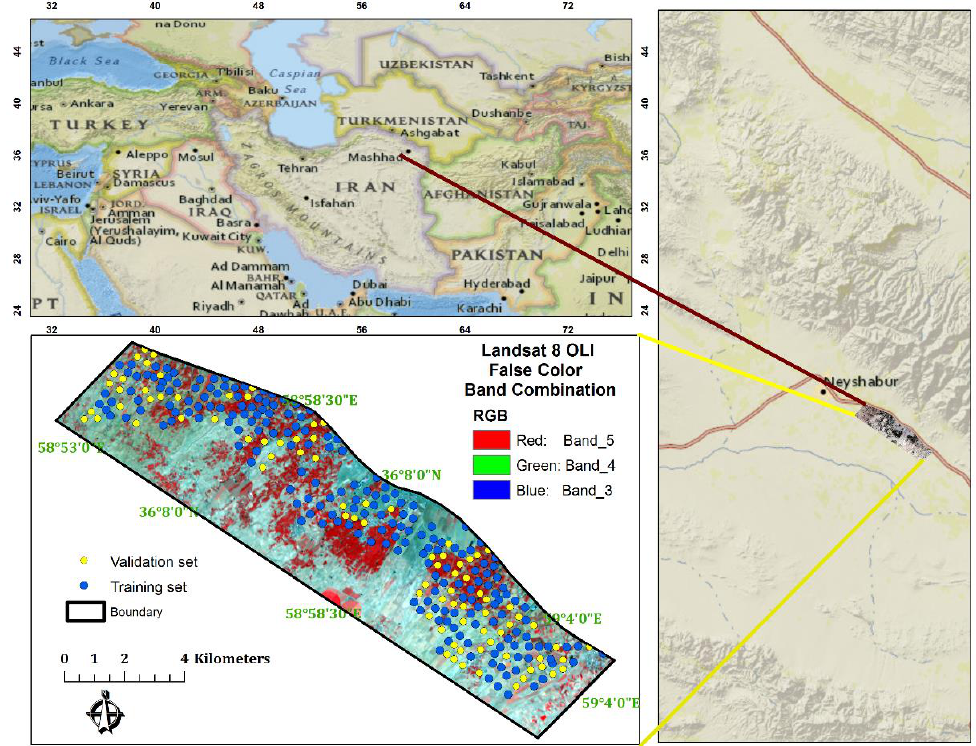
Figure 1. The study area in Northeast Iran and the spatial distribution of the soil samples training and validation set overlaid on a Landsat 8 OLI false color band combination. and validation set overlaid on a Landsat 8 OLI false color band